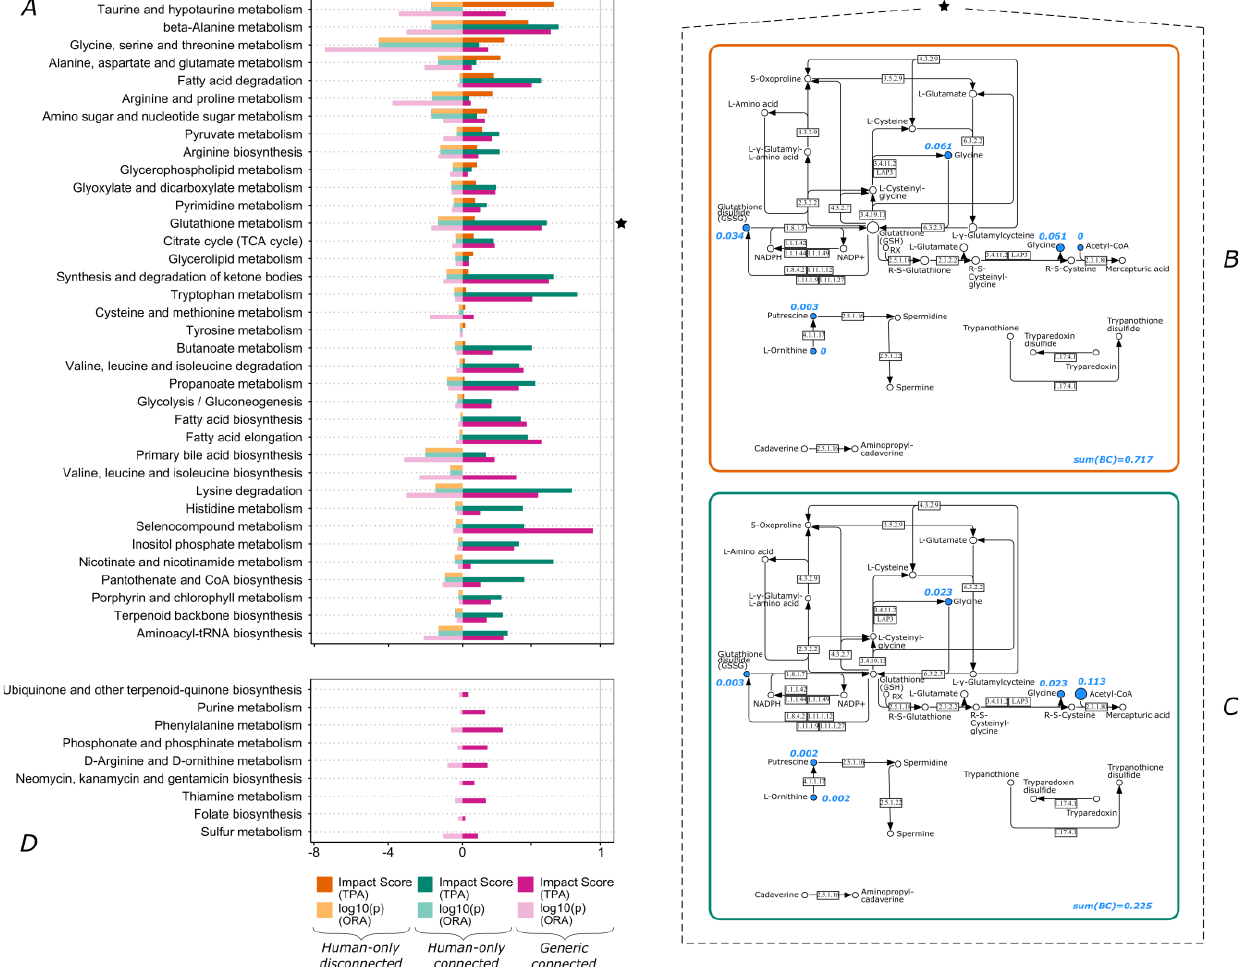
Figure 3. Pathway scoring comparison for dataset 2. ( A ) TPA impact scores and ORA log10(p) values for all pathways (pathways exhibiting zero values in all cases are omitted). ★ “Glutathione metabolism” pathway for ( B ) human-only disconnected and ( C ) human-only connected. Blue color denotes significant compounds in this dataset, blue values are the computed betweenness centrality scores for these nodes, sum(BC) is the sum of betweenness centrality scores for all the nodes of the pathway, and node size corresponds to the relevant betweenness centrality scores of the nodes within the pathway. ( D ) TPA impact scores and ORA log10(p) values for microbiome related pathways.